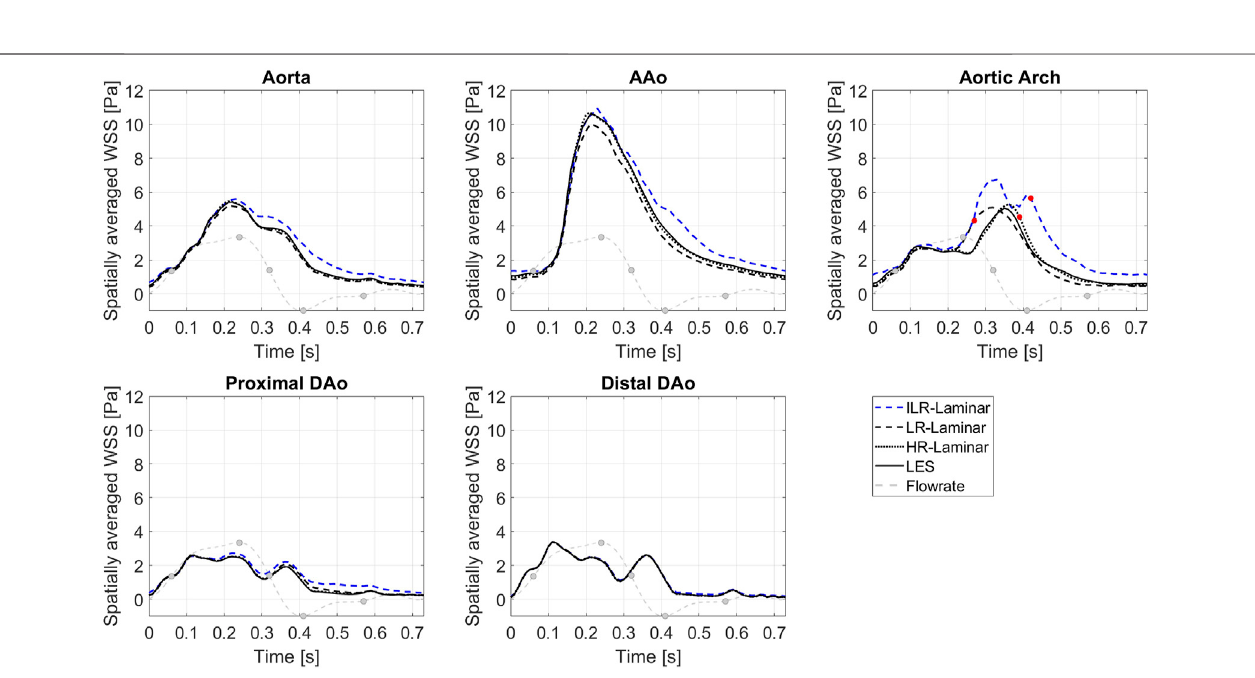
FIGURE 7 | Wall shear stress (WSS) spatially averaged over the entire aorta and each ROI, plotted over the cardiac cycle. Largest differences relative to LES are indicated by red markers. Key times throughout the cardiac cycle are highlighted and refer to maximum acceleration, peak systole, maximum deceleration, end systole and